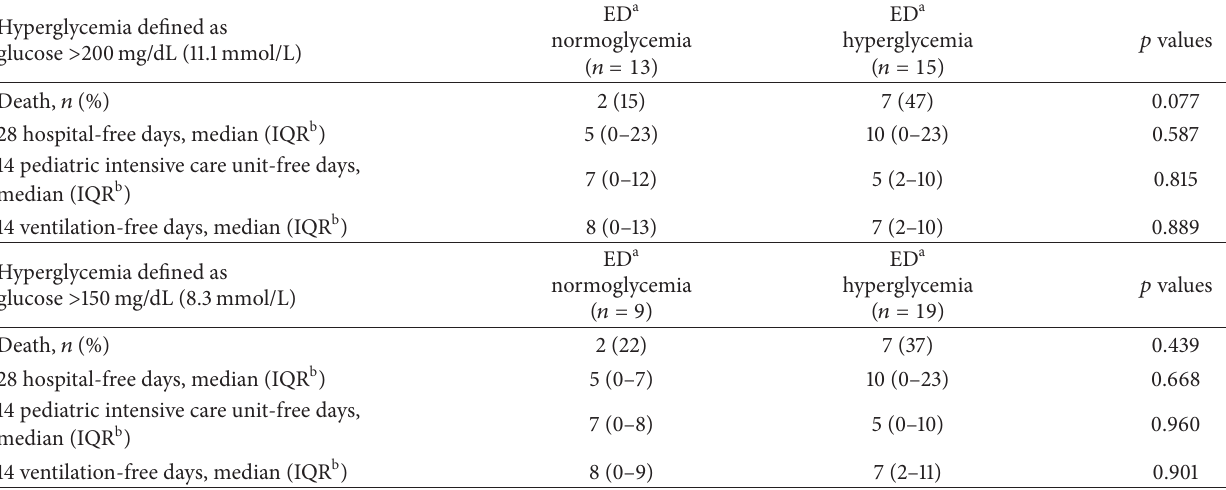
Table 3: Presenting glucose as a predictor for clinical outcomes in patients with GCS ≤ 8 ( 𝑛 = 28